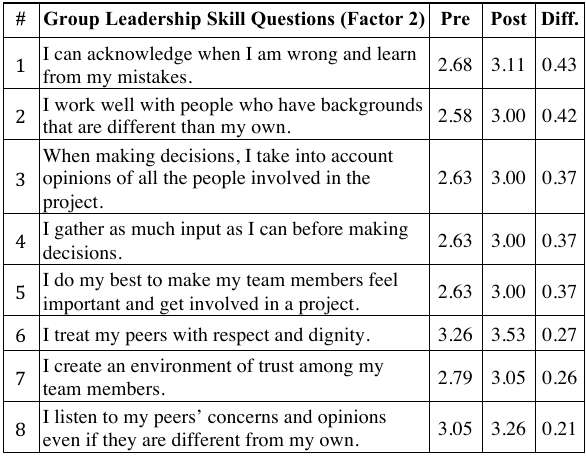
TABLE III. I TEM S CORES FOR G ROUP L EADERSHIP S KILL